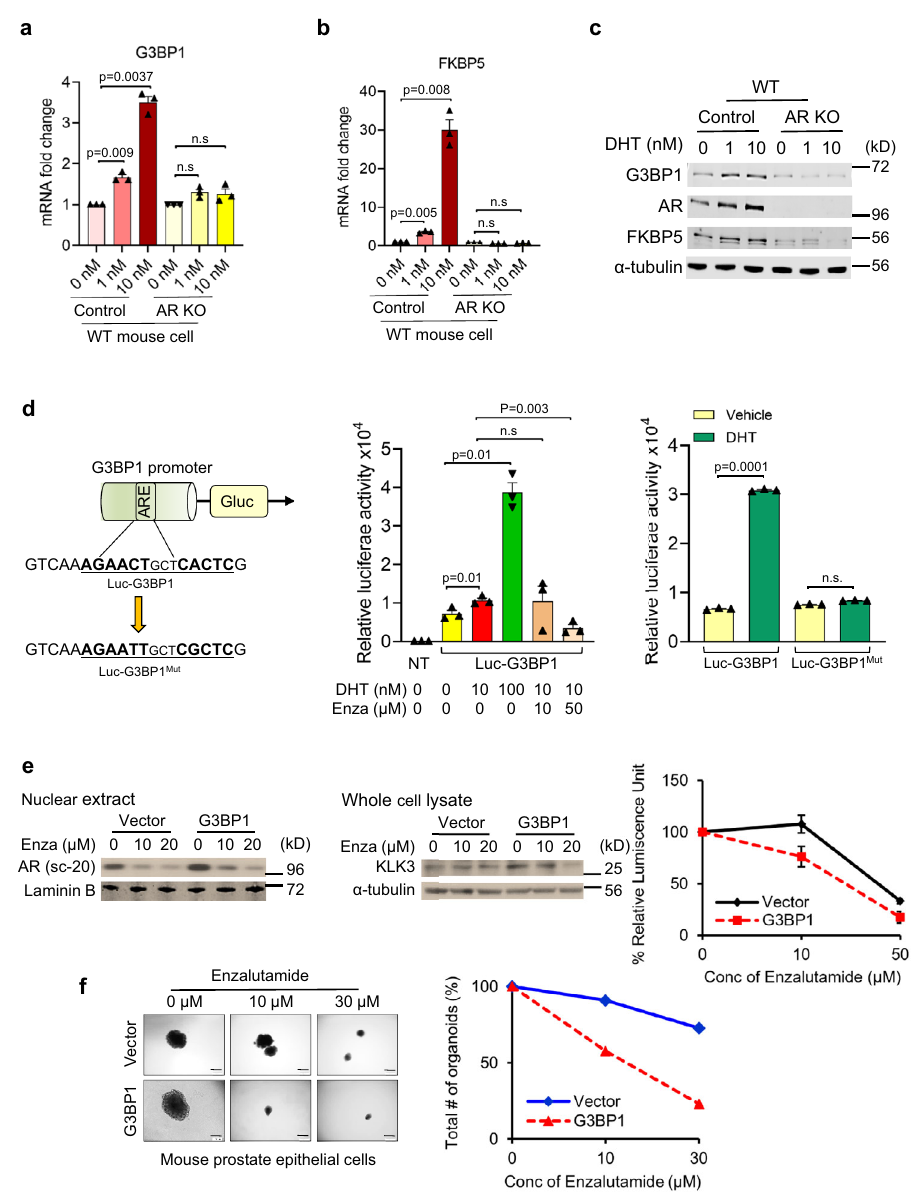
Fig. 5 AR activates G3BP1 transcription to maintain a feed-forward ampli fi cation of AR signaling, resulting in sensitization of G3BP1 high PCa cells to AR-targeted drugs. a , b Control and AR KO mPEC-derived organoids were treated with DHT at the indicated concentrations. Expression of G3BP1 ( a ) and the AR-target gene FKBP5 ( b ) was quantitatively measured by RT-qPCR. n = 3 biologically independent experiments. Error bars, ±S.E.M. p values are indicated in the fi gure. c Immunoblotting of WCL derived from control and AR KO organoids treated with vehicle or DHT for G3BP1, AR, FKBP5, and α - tubulin (loading control). n = 3. ( d left) Schematic diagram of luciferase reporter constructs showing sequence of wild-type (in Luc-G3BP1) and mutant ARE (in Luc-G3BP1 Mut ) in G3BP1 promoter region. ( d , middle) 22Rv1 cells were transfected with G3BP1 promoter luciferase reporter constructs and treated with DHT alone or in combination with enzalutamide (Enza) as indicated. Gaussia Luciferase activity was determined and normalized against secreted Alkaline Phosphatase activity. NT, no transfection. ( d right) 22Rv1 cells were transfected with G3BP1 promoter luciferase reporter (Luc-G3BP1) and G3BP1 promoter luciferase reporter where ARE site is mutated (Luc-G3BP1 Mut ) constructs and treated with 100nM DHT. Gaussia Luciferase activity was determined and normalized against secreted Alkaline Phosphatase activity. n = 3 biologically independent experiments. p value is indicated in fi gure. Error bars, ±S.E.M. e Immunoblots of nuclear extract (left) and whole cell lysate (middle) derived from DOX-inducible empty vector (Ctrl) and pCW57.1-FLAG G3BP1 (overexpressed) 22Rv1 cells treated with enzalutamide for 24h with the indicated concentrations for the indicated proteins. n = 3. Detection of growth inhibition of Ctrl and G3BP1 overexpressed 22Rv1 cells (right) in the presence of enzalutamide with the indicated concentrations using Cell Titer Glow assay. n = 3 biologically independent experiments. Error bars, ±S.E.M. f Photomicrographs of representative mouse prostate organoids (scale bar, 200 µ m) from the indicated mouse genotype treated with enzalutamide with the indicated concentrations following quanti fi cation of organoid number. A representative result from more than three independent experiments is shown. Source data are provided as a Source Data fi le. WCL whole cell